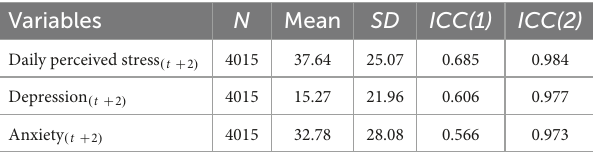
TABLE 1 Descriptive statistics: means, standard deviations, and ICCs.